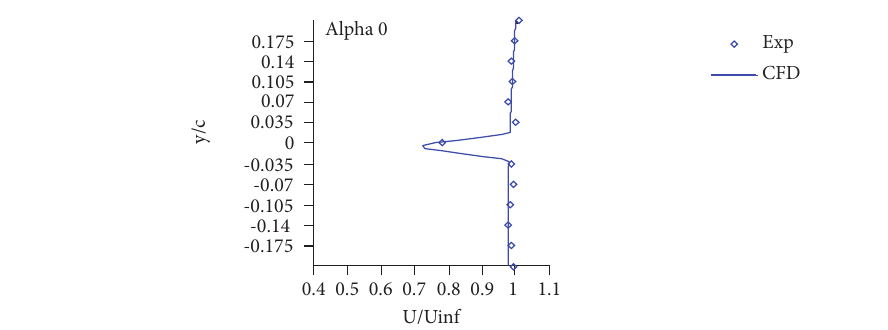
Figure 20. Streamwise velocity profile at x/c = 0.25, Mach =